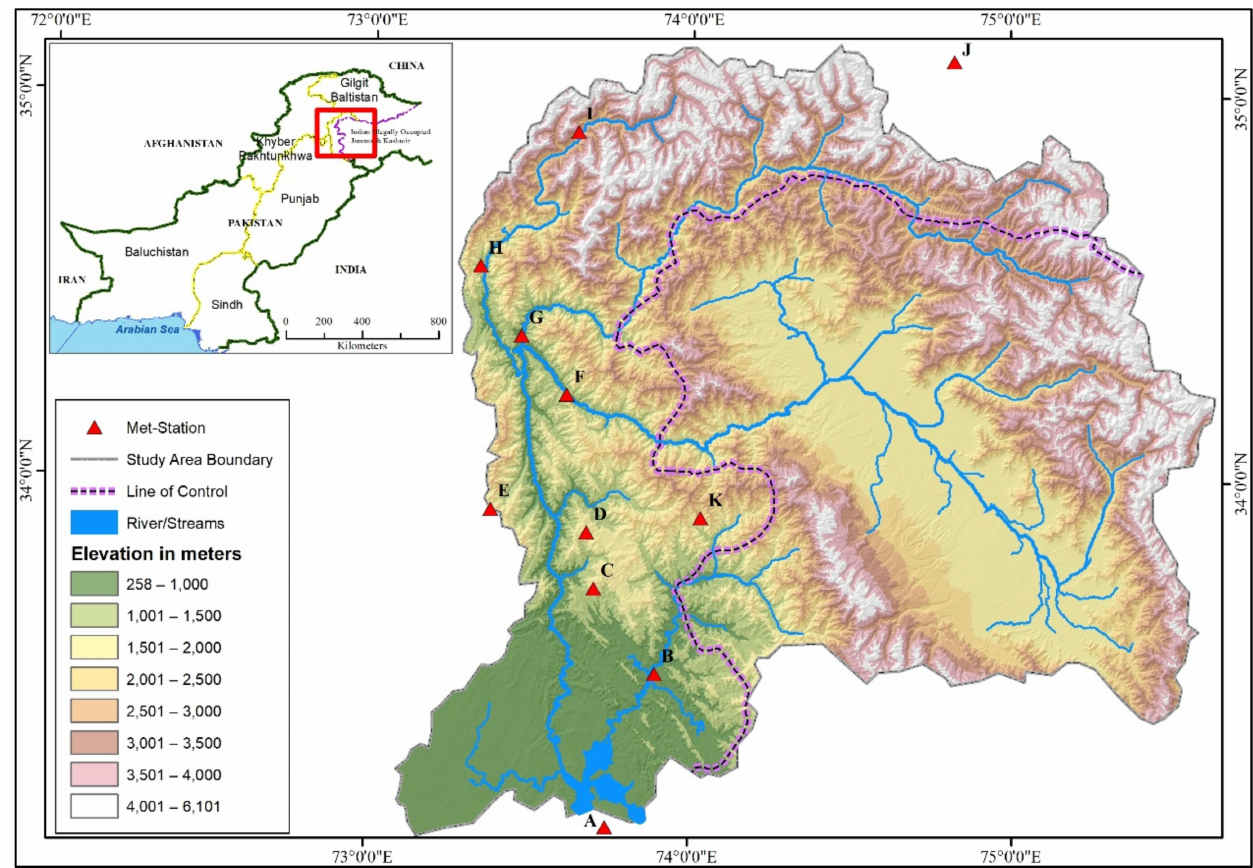
Figure 1. Geographical location of the Jhelum River